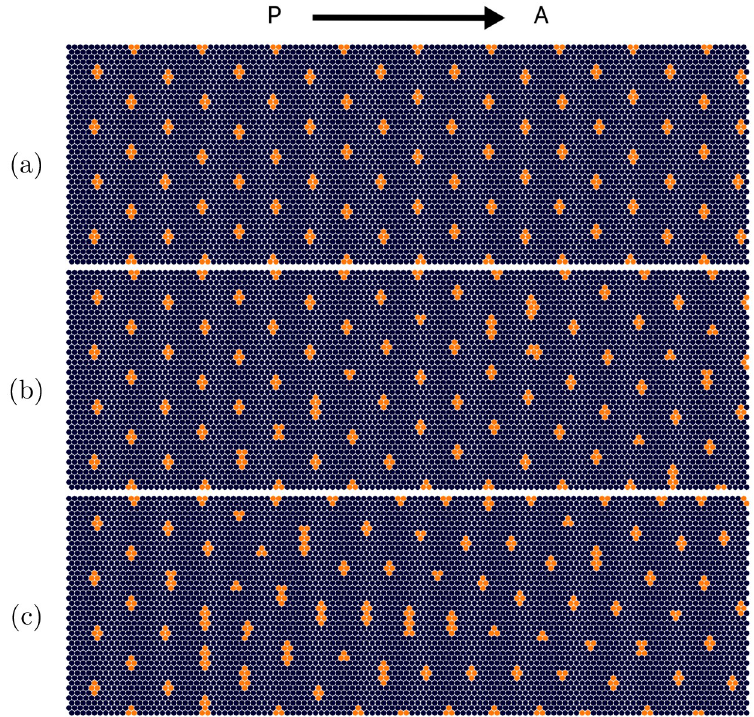
Fig 4. Pattern formation simulation results in the Drosophila eye disc, the morphogenetic furrow moves from left to right. Cluster positions and sizes of ato expressing are shown for increasing noise σ in the diffusivity of the morphogens D u and D s . (a)-(c) are the final patterns for σ / μ = 0, σ / μ = 30%, and σ / μ = 40% respectively. Here, μ is the mean of the corresponding normal distribution and the value that is used to generate the perfect pattern.